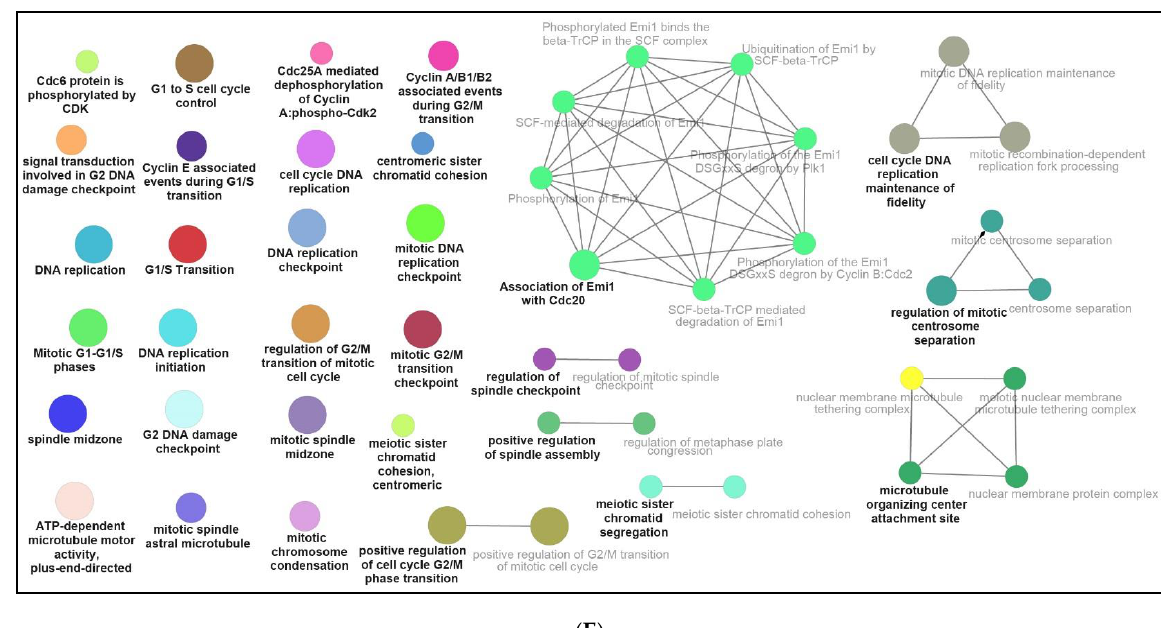
Figure 6. Functional enrichment analysis of down-regulated DEGs from ClueGO. ( A ) Prolactin, opioid signaling pathway, and osteoclast fusion; ( B ) Toll-like receptor signaling pathway; ( C ) fatty acid metabolism; ( D ) inflammation and cytokine; and ( E ) cell checkpoints, cell cycle and cell structure.